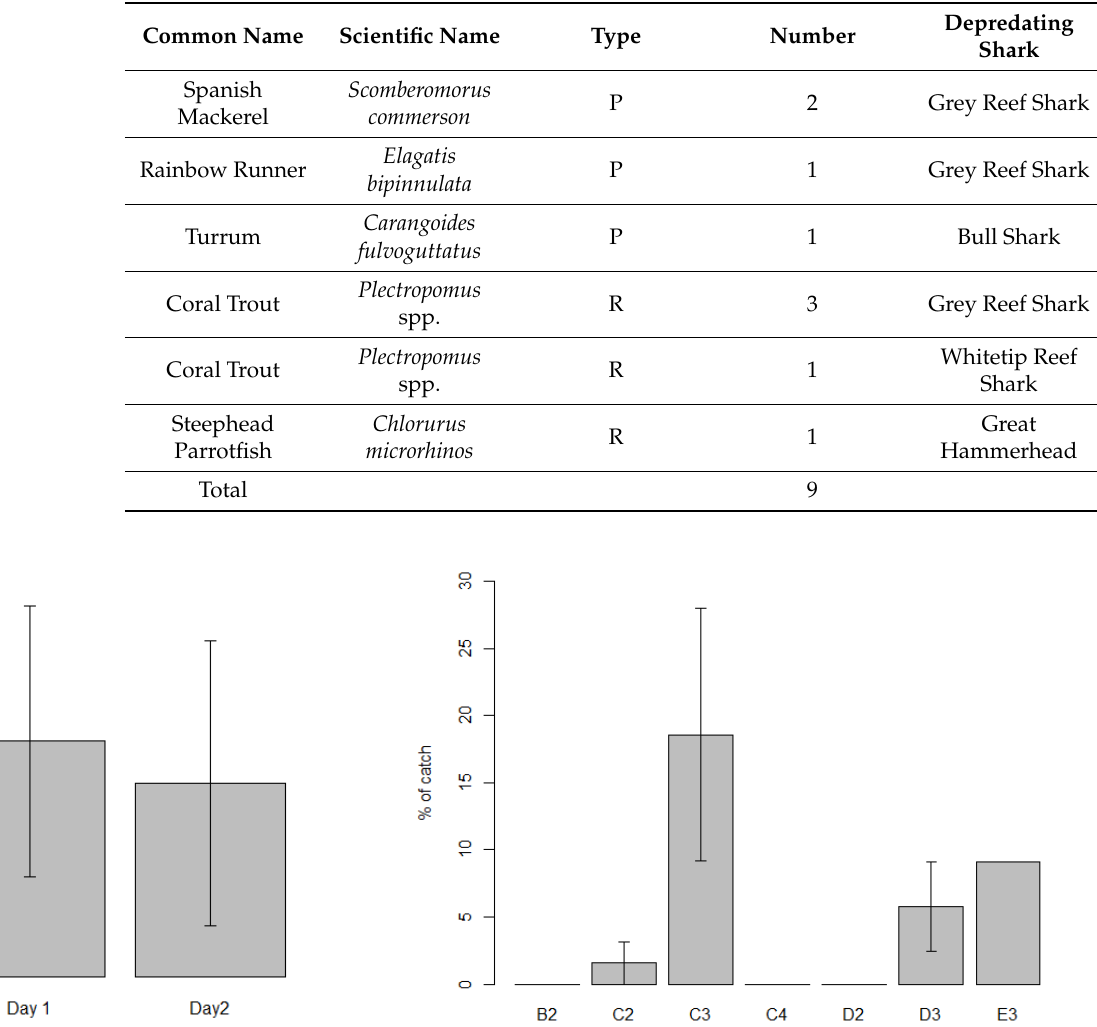
Table 5. Species of fish depredated by sharks during the NQBI in 2021. Key: P—Pelagic, R—Reef.